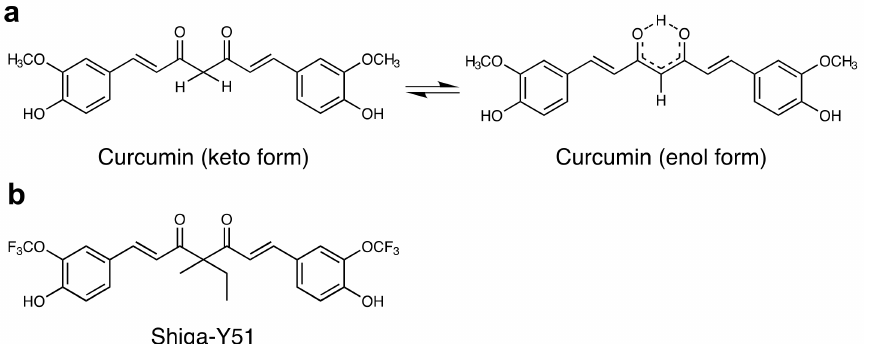
Figure 1. Chemical structures of curcumin and Shiga-Y51. ( a ) Curcumin, a yellow-orange pigment in turmeric, exists in an equilibrium between keto and enol tautomers. ( b ) Shiga-Y51 is a fluorinated curcumin derivative with a fixed keto form by the methyl and ethyl groups at the C4